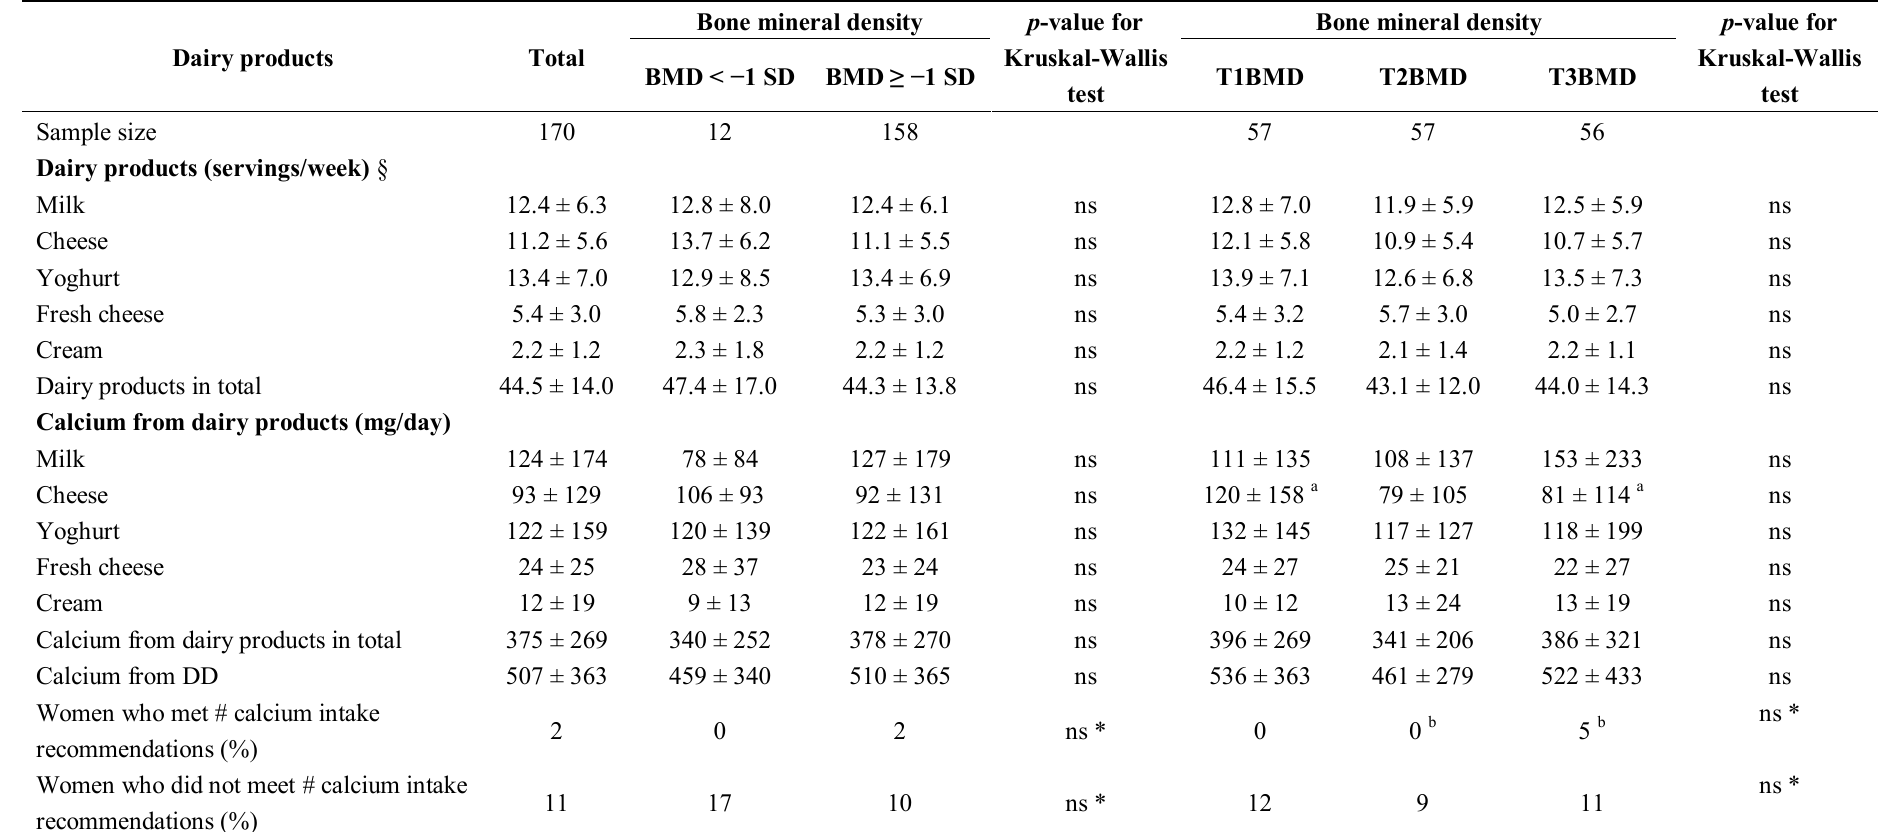
Table 3. Consumption of dairy products and calcium from dairy products and daily diet (DD) in relation to bone mineral density (BMD) in women (mean ± standard